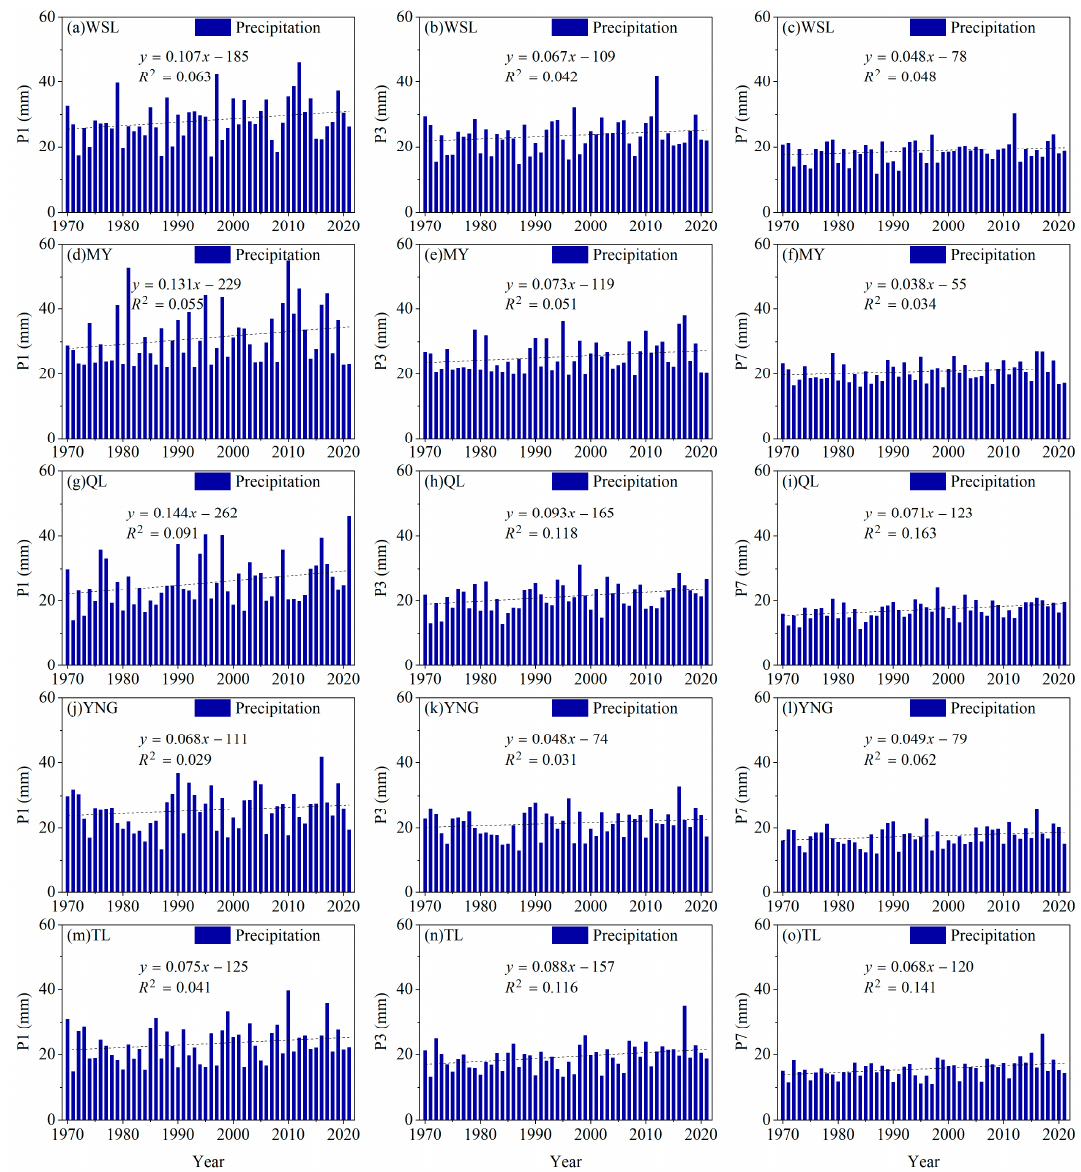
Figure 7. Temporal variations in precipitation indices at meteorological stations in the QM region. The stations are, WSL: Wushaoling; MY: Menyuan; QL: Qilian; YNG: Yeniugou; TL: Tuole. ( a − c ) WSL; ( d − f ) MY; ( g − i ) QL; ( j − l ) YNG; ( m − o ) TL. De fi nitions of these precipitation indices are given